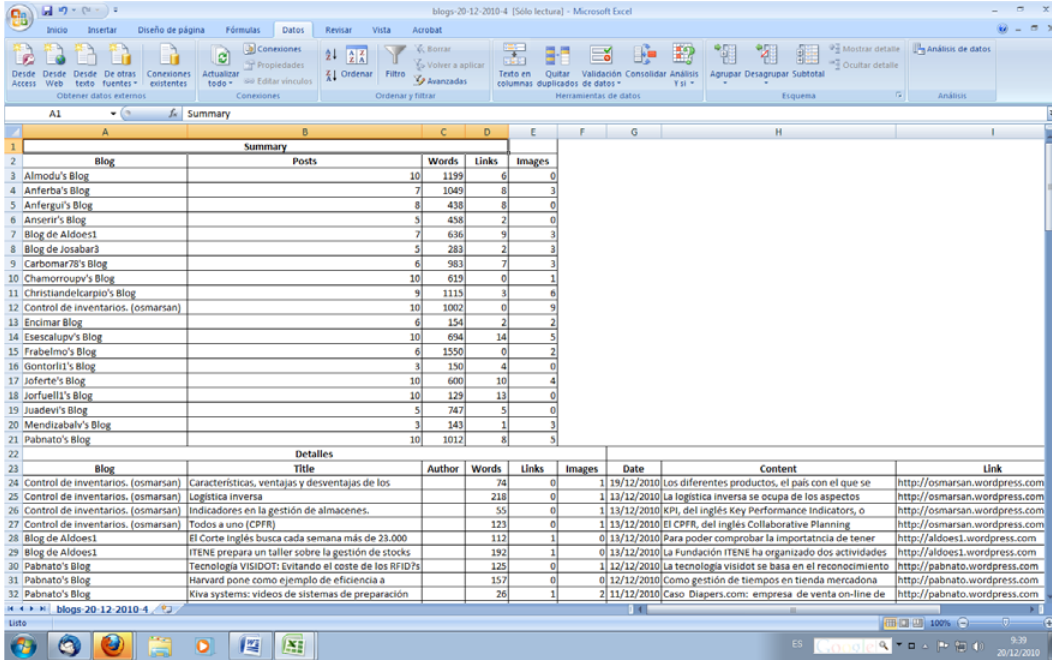
Figure 2. “Excel to analyze the